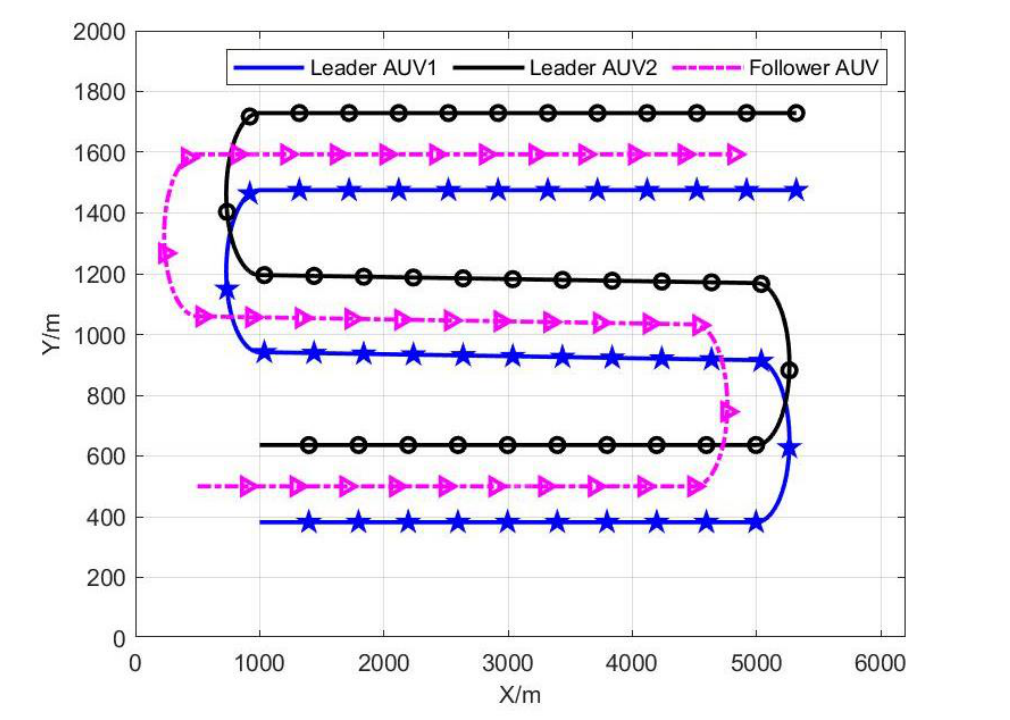
Figure 2. Real trajectories of leader and follower